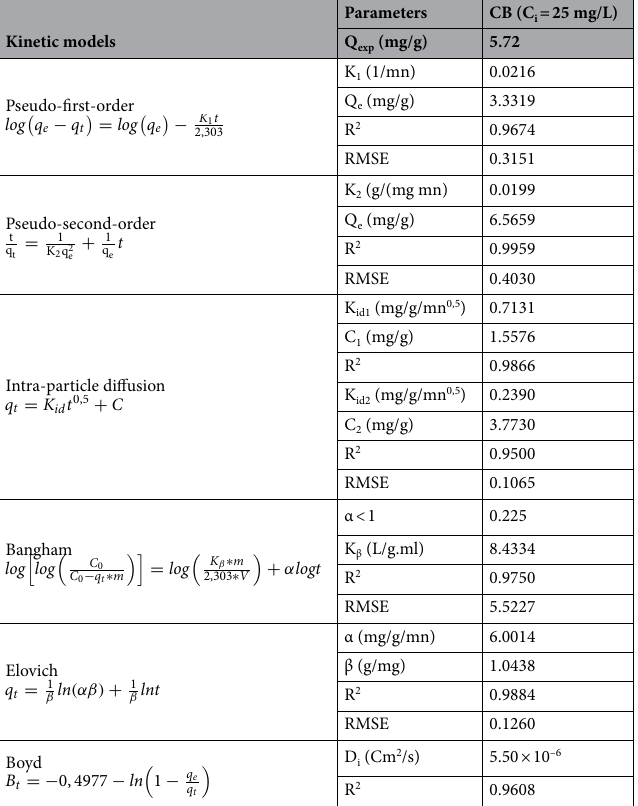
Table 4. Parameters of the kinetic models studied for Cibacron blue biosorption on Bean peel (BP) biosorben.